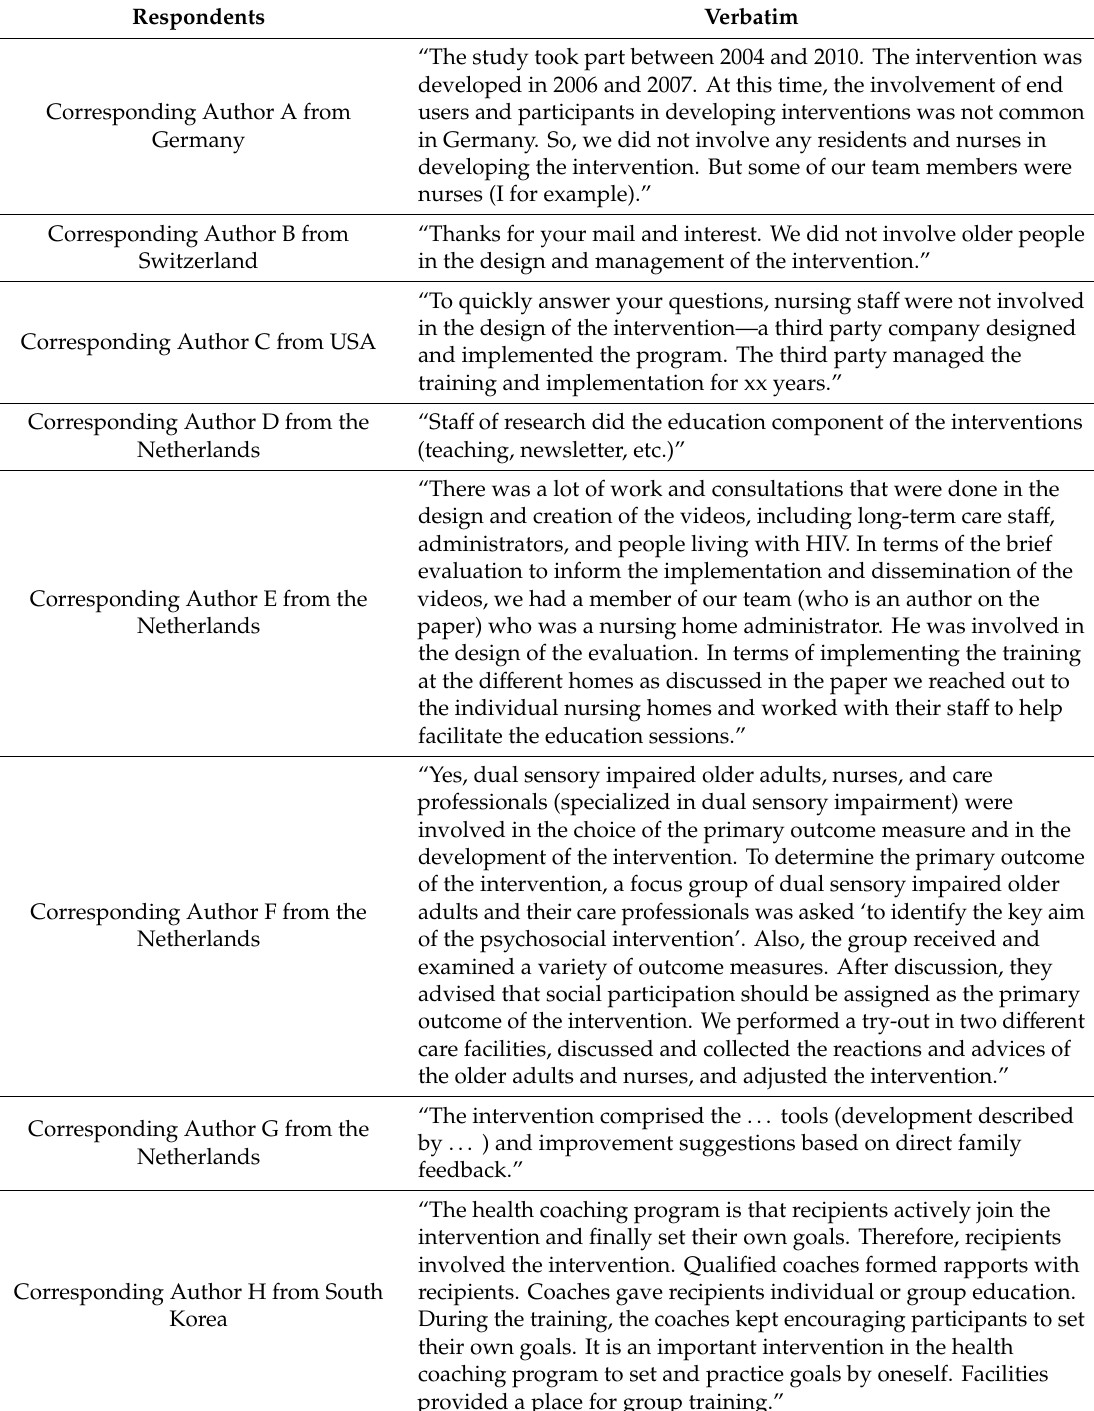
Table 3. Answers of corresponding authors to the open-ended